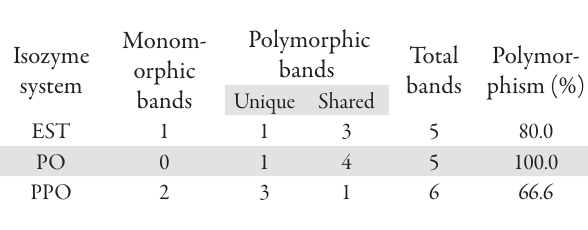
Tab. 2. Number and types of isozymes bands as well as the total polymorphism percentages generated in the five different